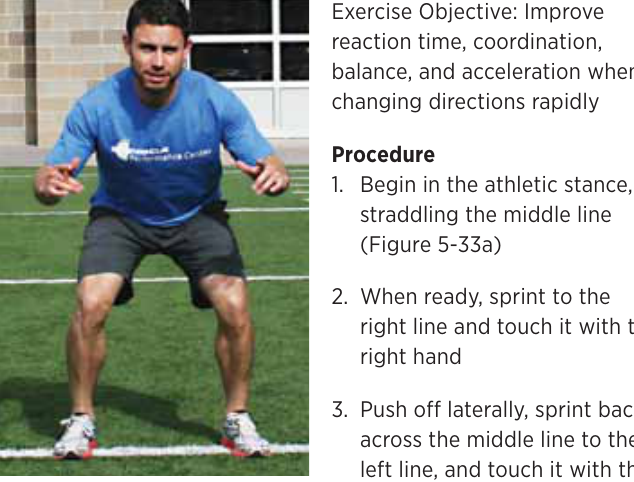
Figure 5-33a. Starting